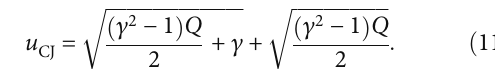
= 30 ). (a) Density. (b) A